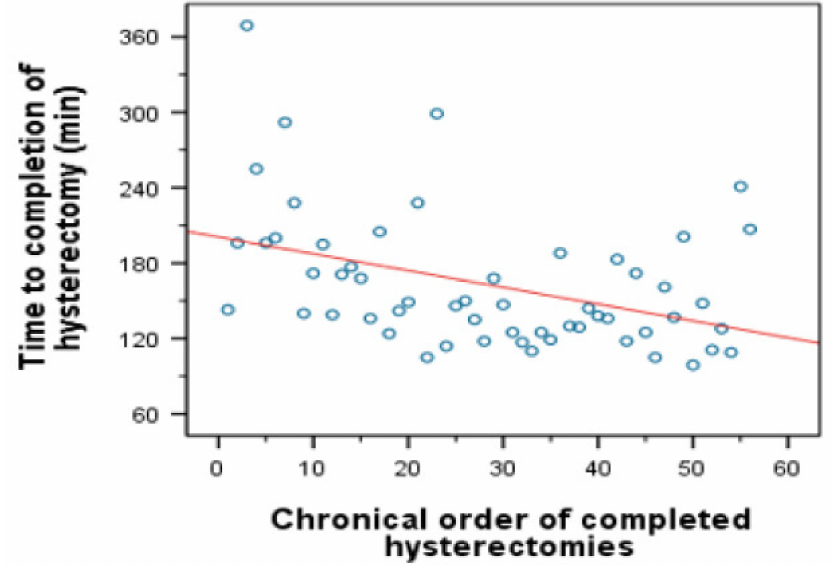
Figure 2. Linear regression for operating